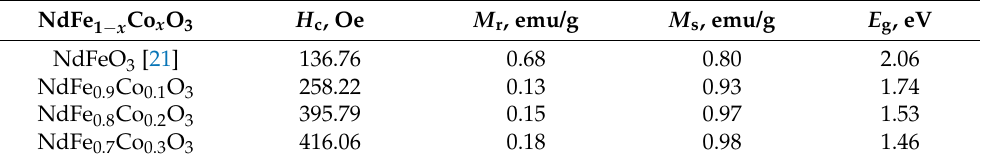
Table 3. Optical and Magnetic characteristics of NdFe 1 − x Co x O 3 nanomaterials annealed at 750 ◦ C for 60